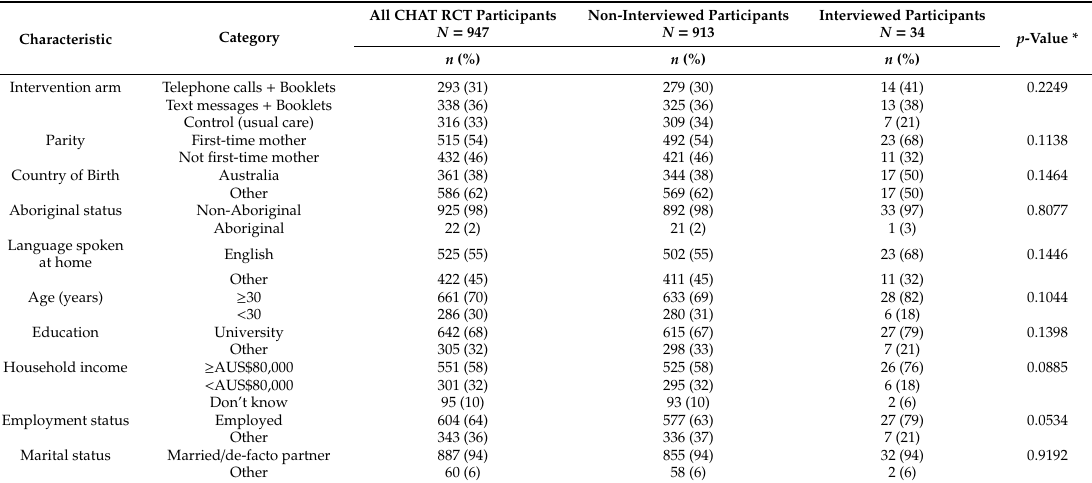
Table 2. Demographic characteristics of